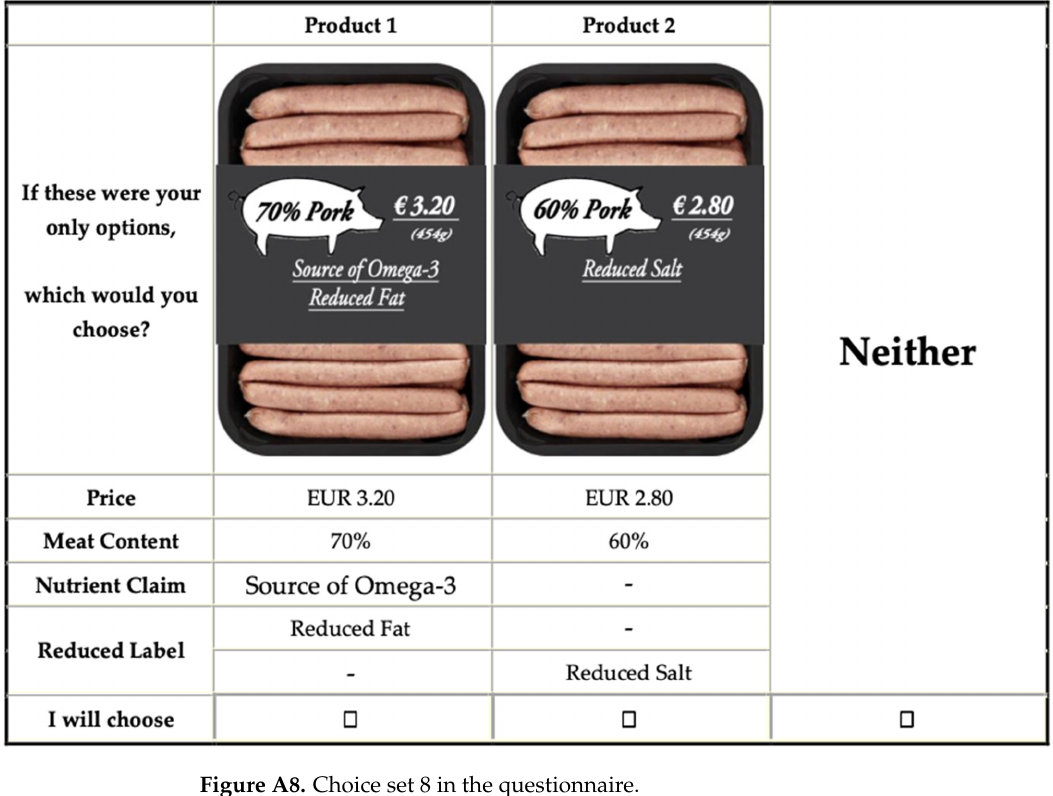
Figure A8. Choice set 8 in the questionnaire.